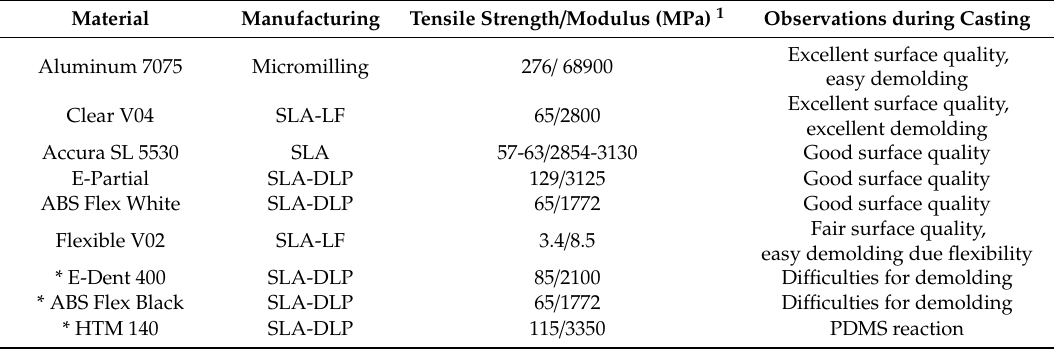
Table 2. Qualitative assessment of photopolymers and additive manufacturing